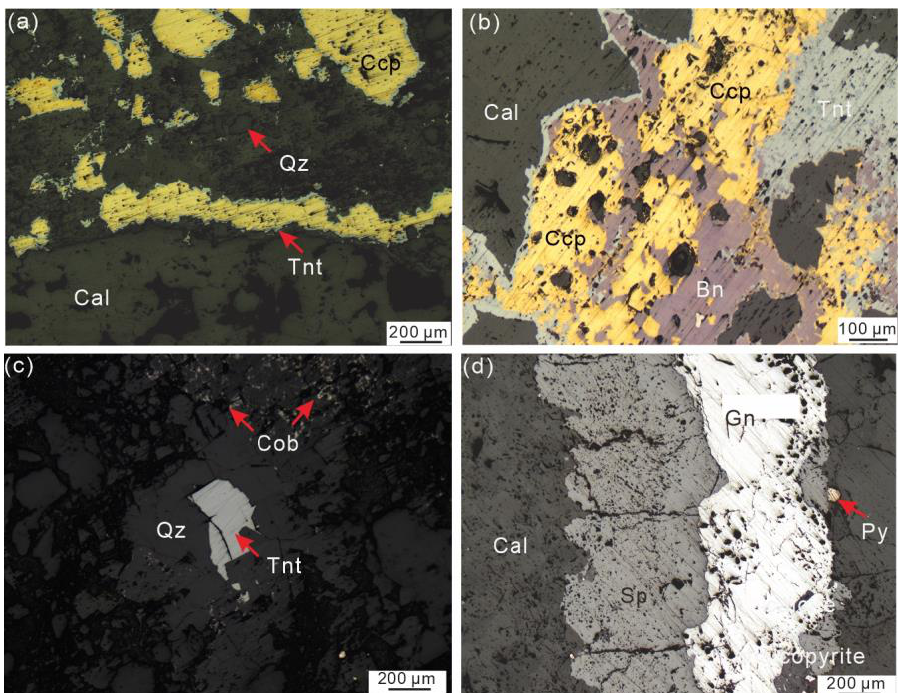
Figure 3. Optical and scanning electron microscopy images of the main mineralization at the Baiyangping Cu – Co – Pb – Zn deposit showing ( a ) early chalcopyrite – tennantite – calcite paragenesis; ( b ) early chalcopyrite – tennantite – bornite – calcite paragenesis; ( c ) early cobaltite – tennantite – quartz paragenesis; and ( d ) late galena – sphalerite – pyrite – calcite paragenesis. Abbreviations: Bn = bornite, Cal = calcite, Ccp = chalcopyrite, Cob = cobaltine, Dol = dolomite, Gn = galena, Tnt = tennantite, Qzt = quartz, and Sp = sphalerite.